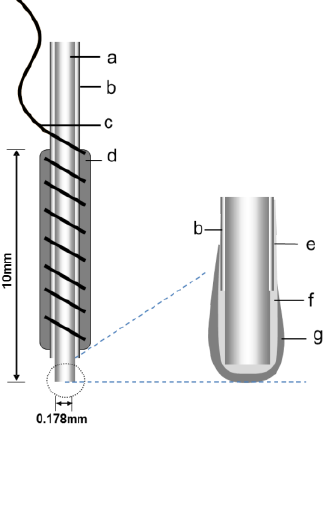
Figure 1. Schematic diagram of the needle-type biosensor. ( a ) Pt-Ir wire, ( b ) Teflon